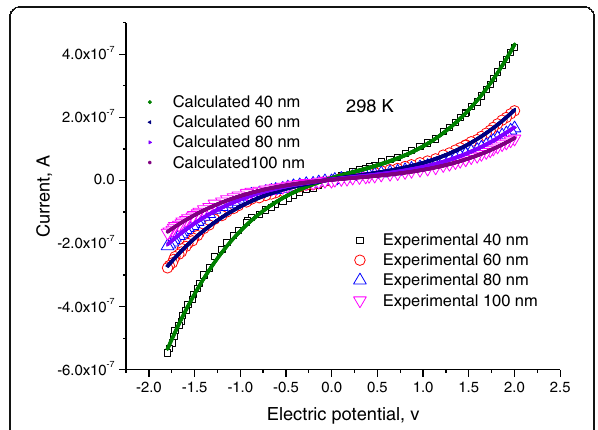
Fig. 4 I - V characteristics at different lengths of DNA molecule: L DNA 40, 60, 80, 100 nm